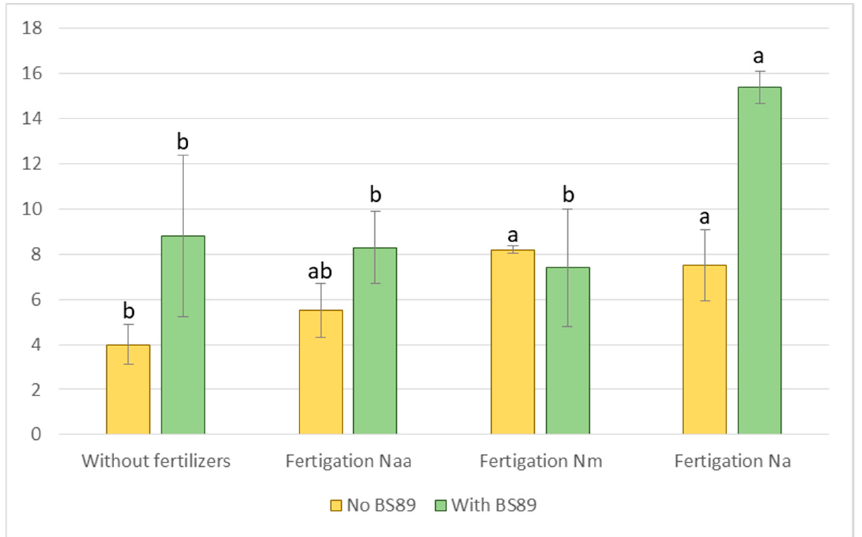
Figure 1. The effect of nitrogen fertilizers and PGPR Bacillus velezensis BS89 on the root weight of cv. Rusich strawberry plants, October 2020 (root weight, grams). The bars are means of three replications per variant. Bars show ± SE, and different letters show a significant difference at the p ≤ 0.05 level, as determined by Duncan’s multiple tests.